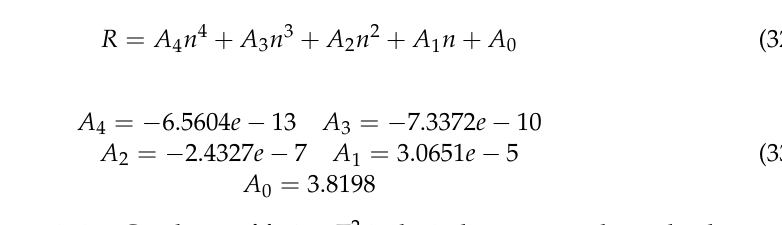
N Table 4. Comparison before and after layup optimisation. Strength Ratio/R